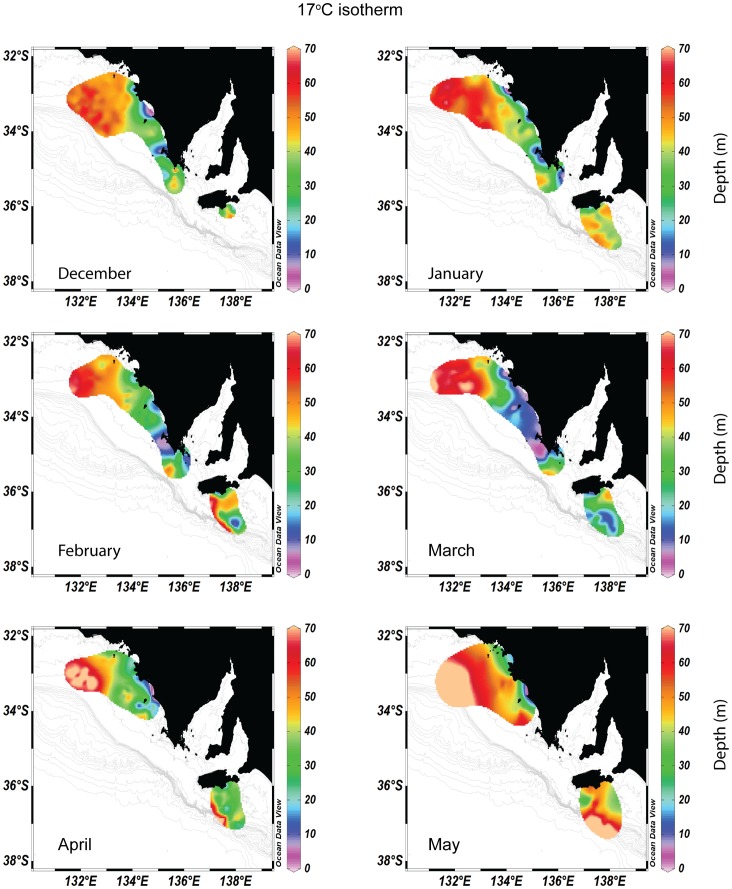
Depiction of cold water upwelling along the South Australian coast as a function of the depth of the 17°C isotherm across the study region between December 2009 and May 2010.Temperature profile data from Conductivity, Temperature and Depth (CTD) tags deployed on seven adult male Australian sea lions during the austral summer upwelling event in 2010. The 17°C isotherm was detected in relatively shallow waters (<40 m) as late as April throughout the geographical range of the study. Wind-trapped pockets of cold water were consistently detected at the surface at Price Island and West Waldegrave throughout most of the study.